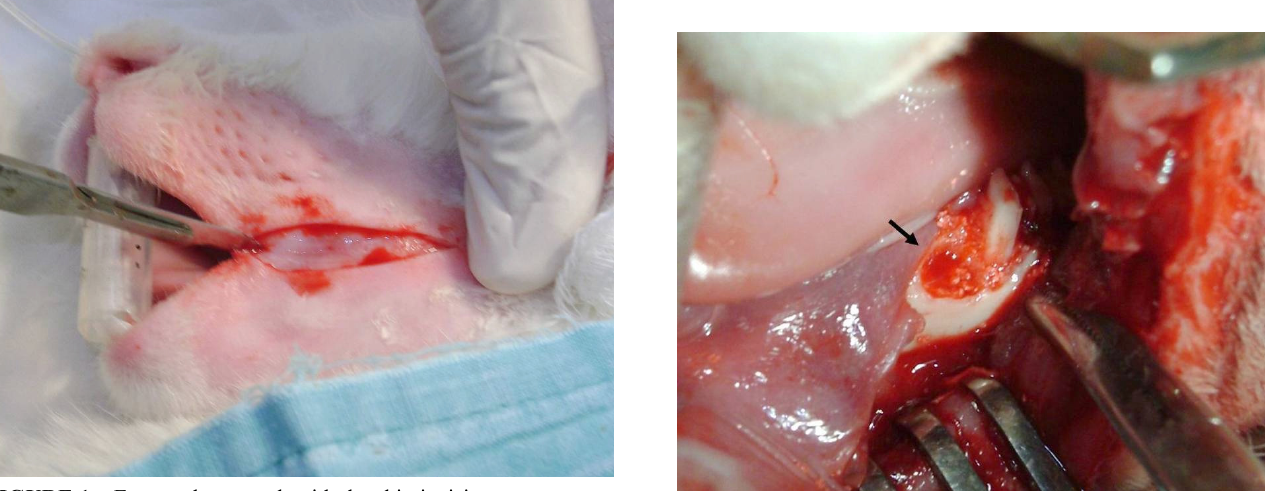
FIGURE 1 – Extraoral approach.with the skin incision.